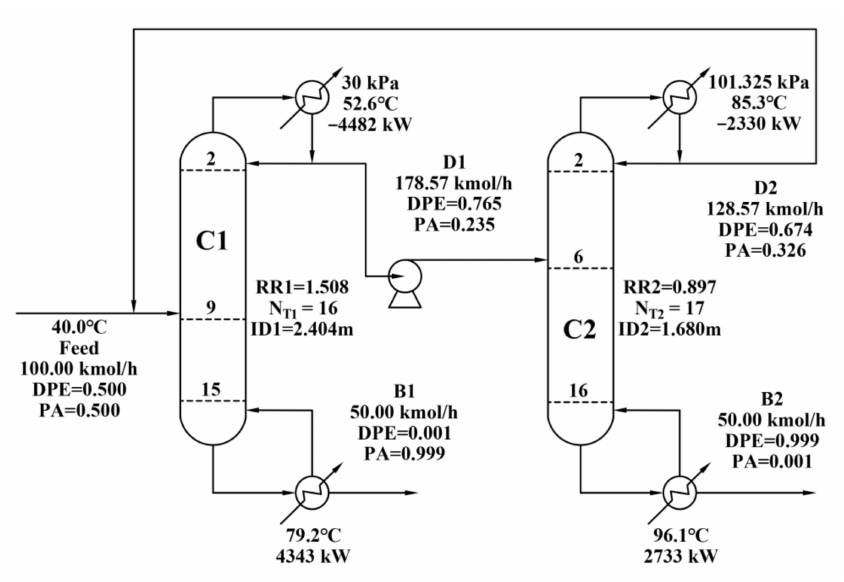
Figure 8. Process flow diagram of the PSDS.